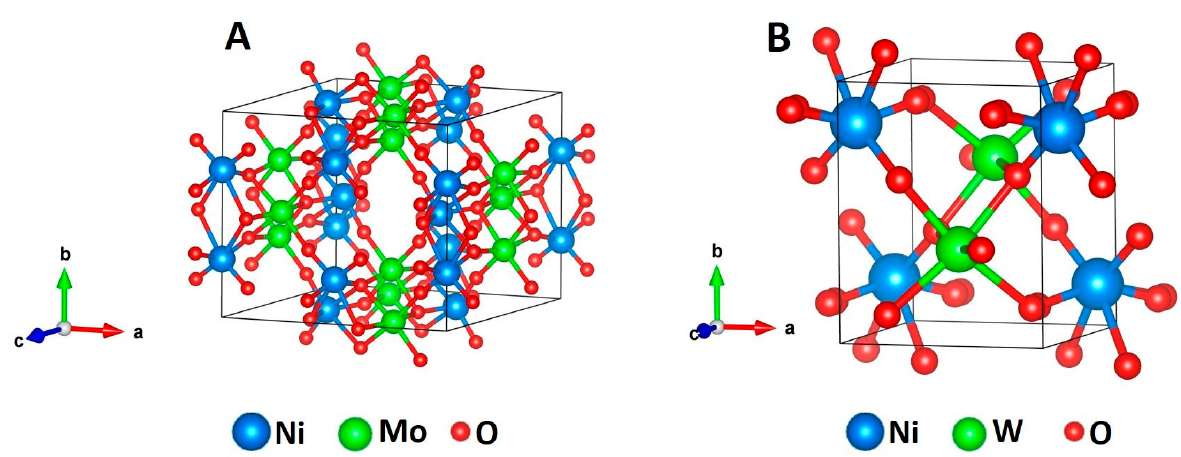
Figure 3. Crystal structure of monoclinic ( A ) α -NiMoO 4 and ( B ) NiWO 4 illustrating the coordination relationship of NiO 6 with MoO 6 octahedra and distorted WO 6 in NiMoO 4 and NiWO 4 , respectively.